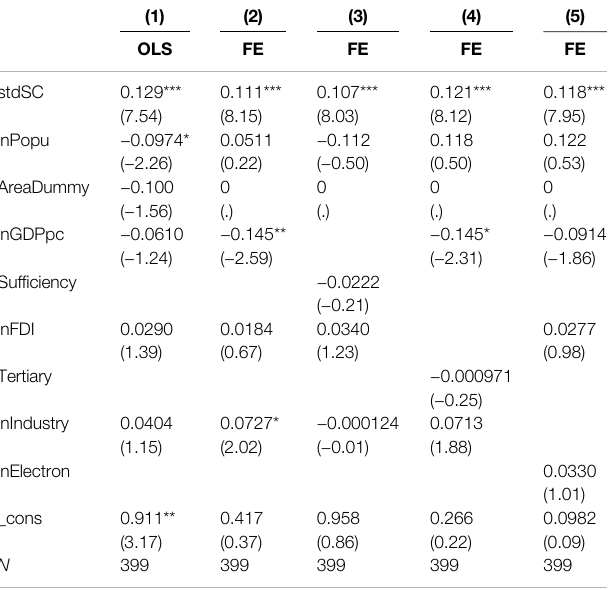
TABLE 2 | Benchmark regression